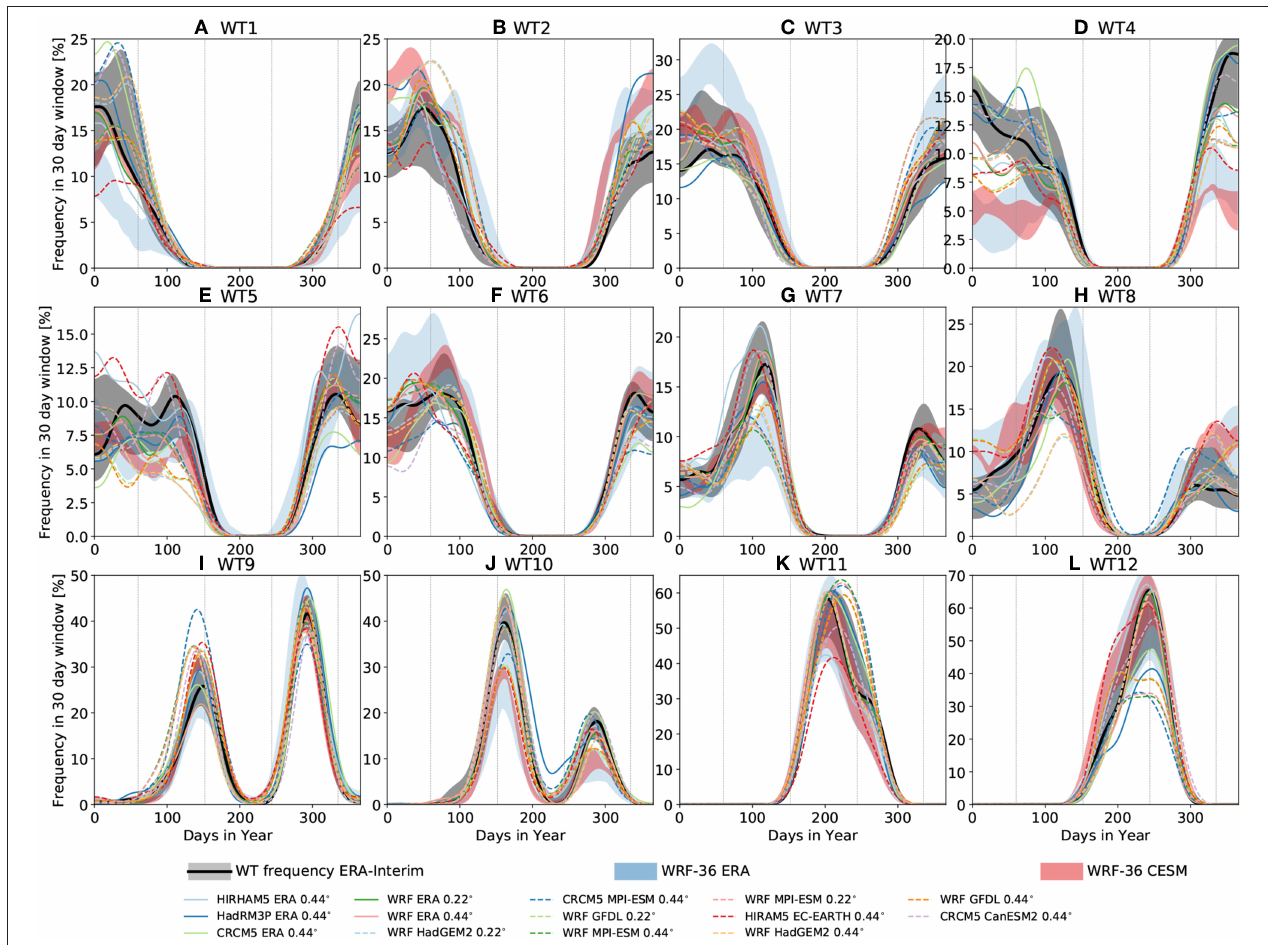
FIGURE 5 | Annual cycle of WT frequencies smoothed by a Gaussian low-pass filter with 10-day standard deviation for each of the 12 WTs (A–L) . The thick black line shows ERA-Interim WT frequencies for the period 1990–2000 and the gray contour shows the spread in all possible 11-year contiguous ERA-Interim periods within 1979–2014 as an estimate of climate variability. The blue contour shows the spread in the 24-member WRF36 ensemble that uses ERA-Interim as driving data. The red contour shows the spread within the 3-member CESM driven WRF36 hindcast simulations. Colored solid/dashed lines show WT frequencies in NA-CORDEX hindcast/historical simulations. The RCM results are based on the period 1990–2000. Vertical dashed lines show the end of February, May, August, and November respectively from left to